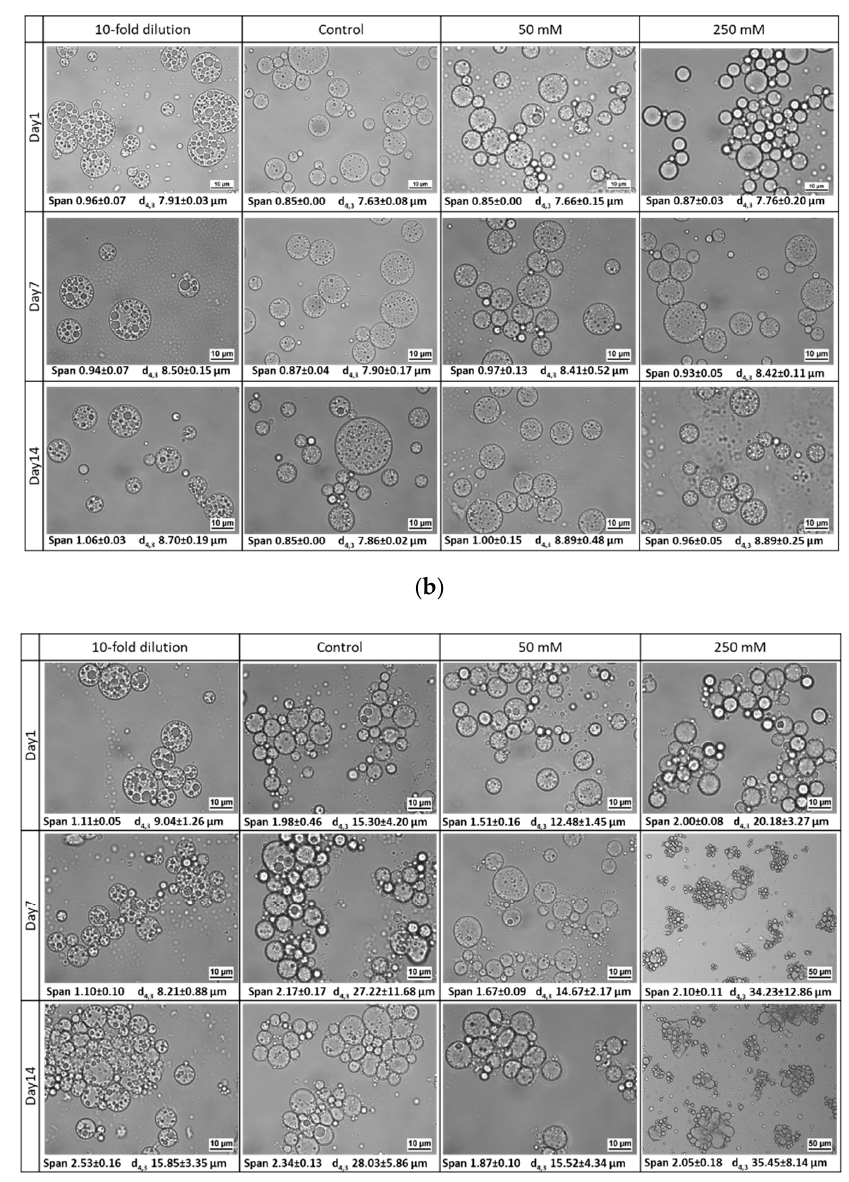
Figure 12. Microstructure of W 1 /O/W 2 emulsions stabilized with LMPC ( a ), WPI ( b ) and PPI ( c ) after addition of 50 mM NaCl ( Δ ( П W2 – П W1 ) = 0.46 MPa), 250 mM NaCl ( Δ ( П W2 – П W1 ) = 2.56 MPa) and 10-fold of water dilution ( Δ ( П W2 – П W1 ) = − 0.54 MPa) of W 2 during a storage period of 14 days.